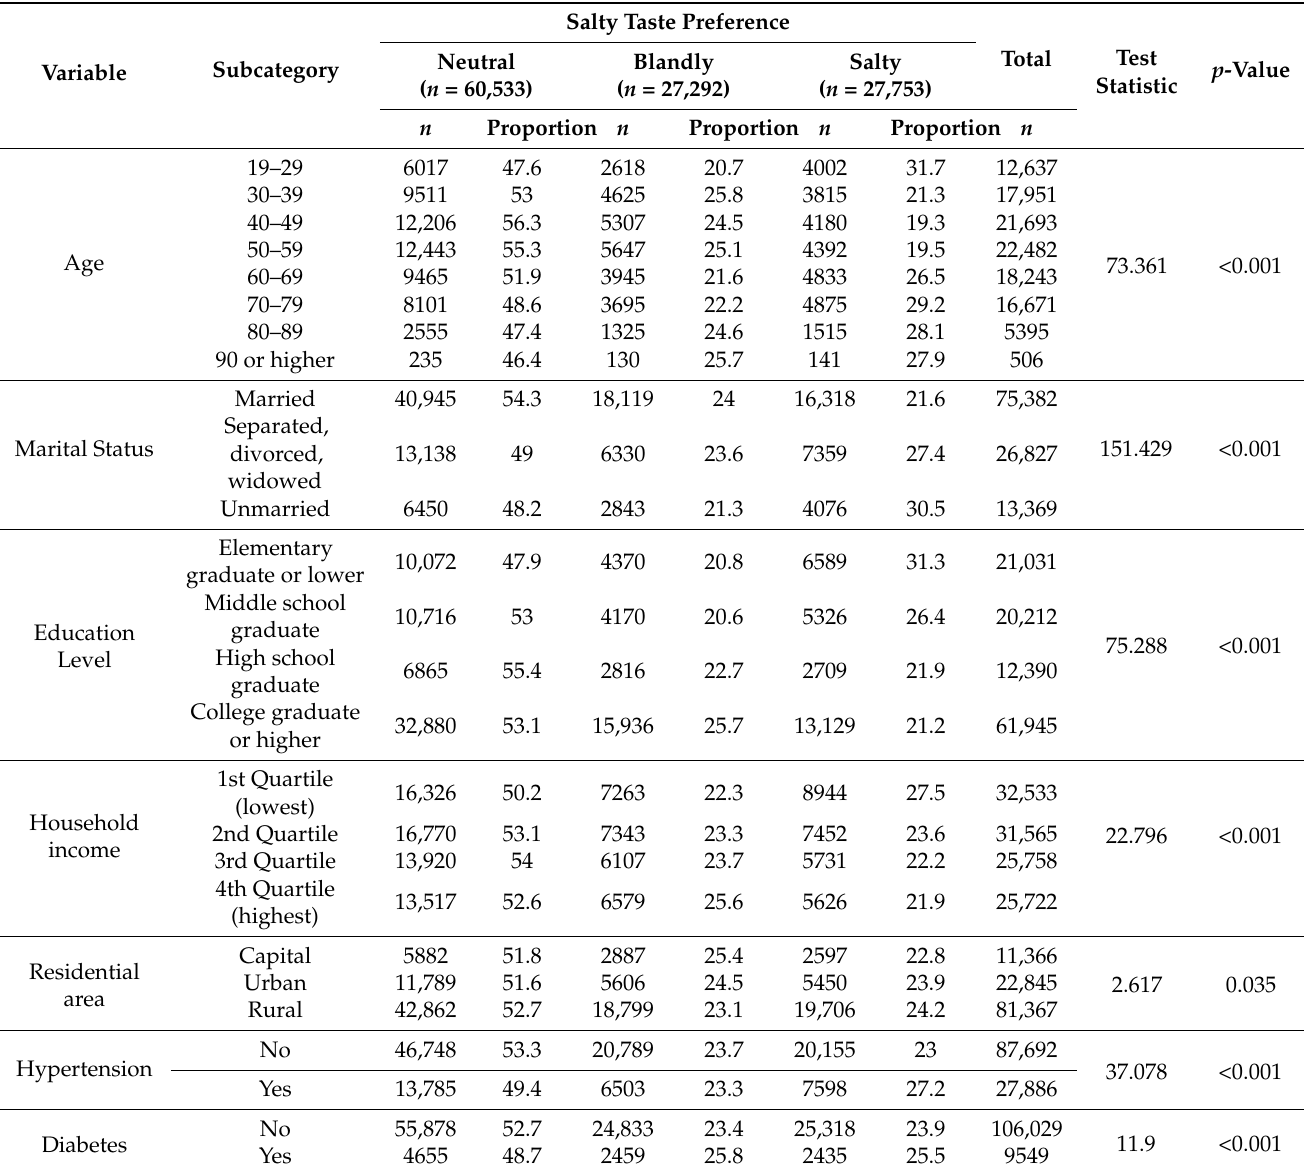
Table 1. Characteristics of study participants by salty taste